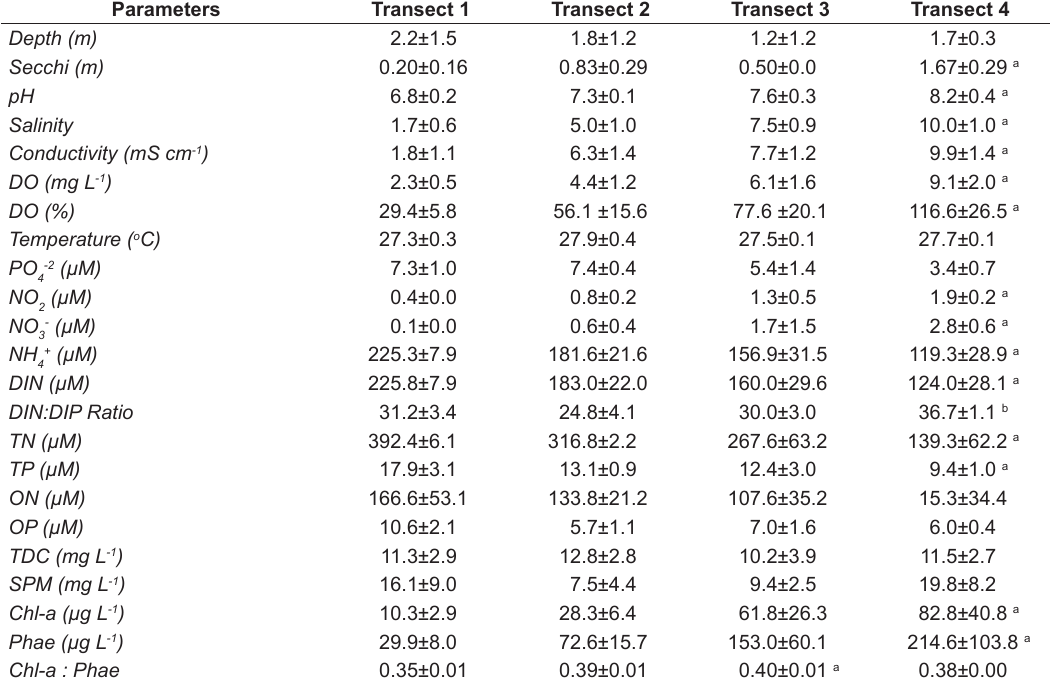
Table 1. Mean and standard deviation of physical-chemical and nutrient concentrations in superficial waters of Iguaçu River mouth, Guanabara bay-RJ.